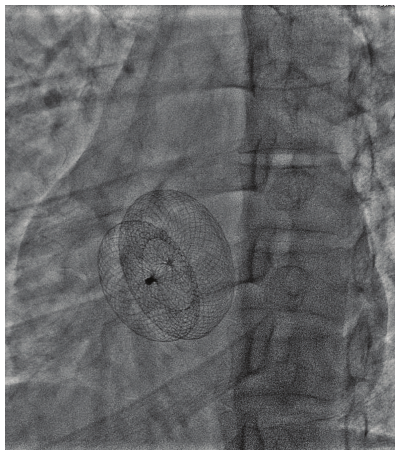
Figure 5: After releasing the